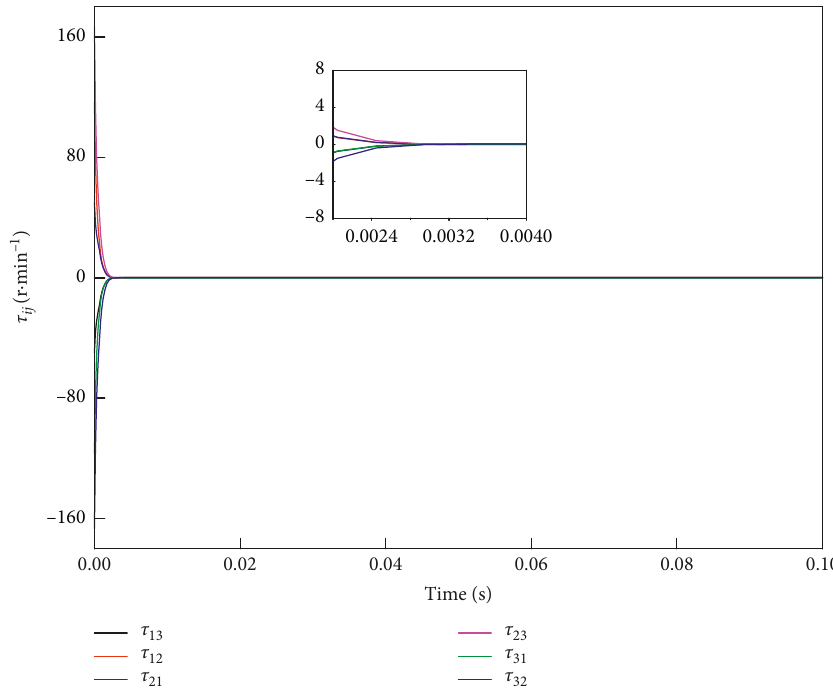
Figure 7: The synchronization error curves of all servos under the sliding mode variable control.